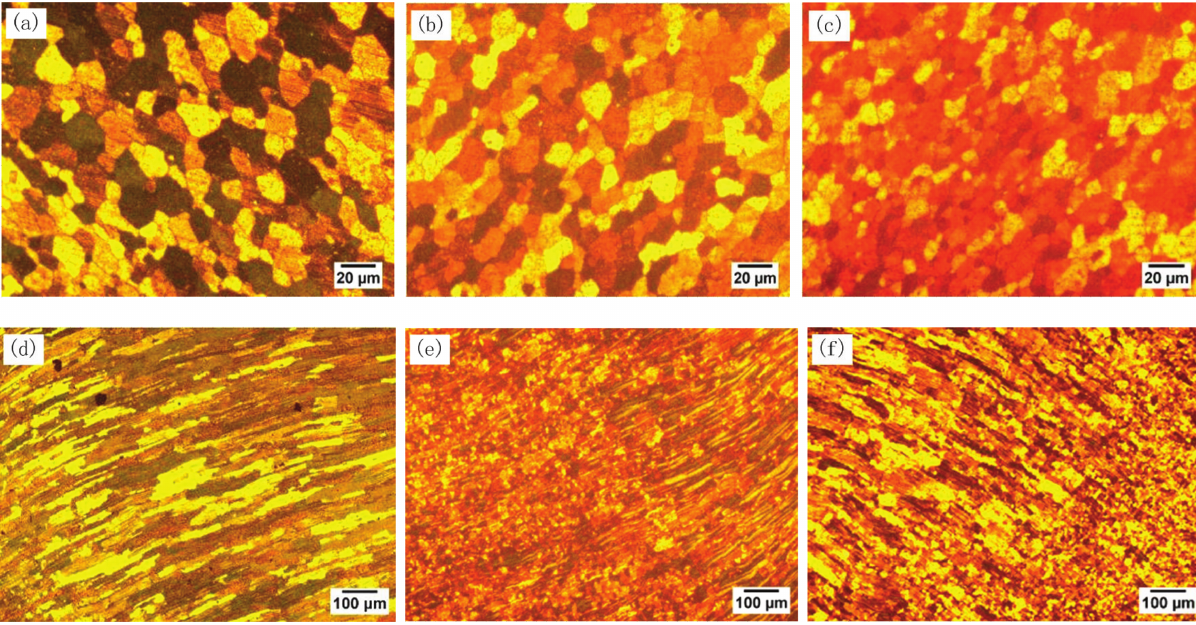
Figure 2: Microstructures of the original and repaired joints: (a) NZ of original joint; (b) NZ of the once repaired joints; (c) NZ of the twice repaired joints; (d) TMAZ of original joint; (e) TMAZ of the once repaired joints; (f) TMAZ of the twice repaired joints.